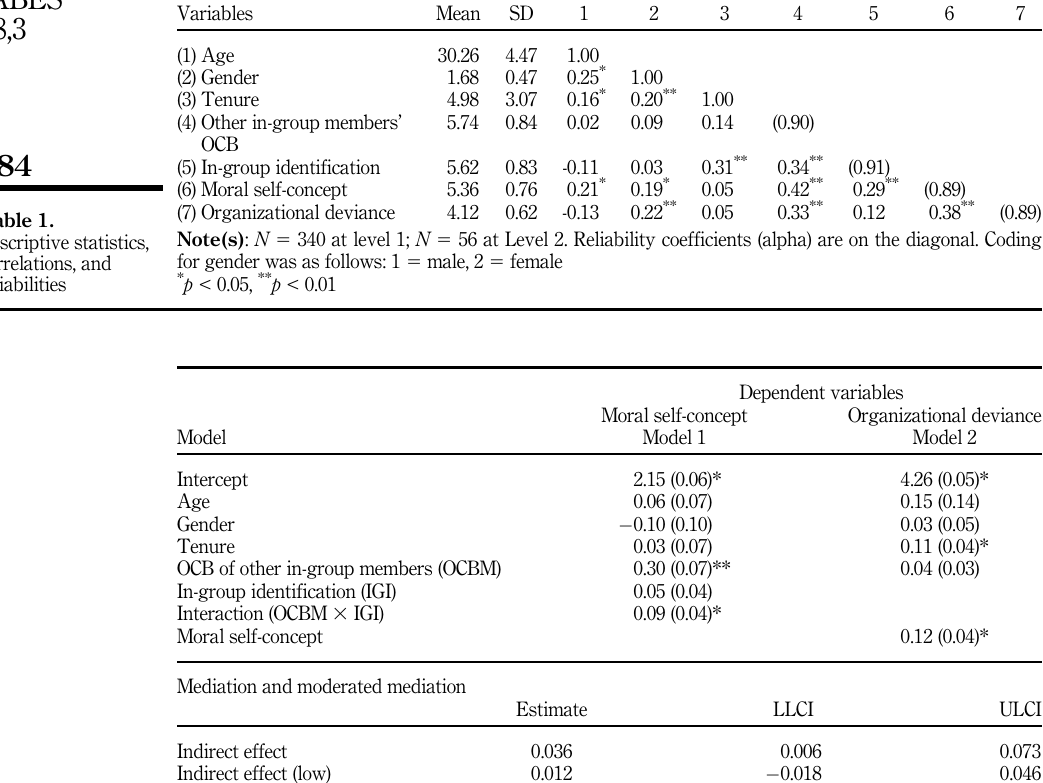
Table 2. Results of multilevel path